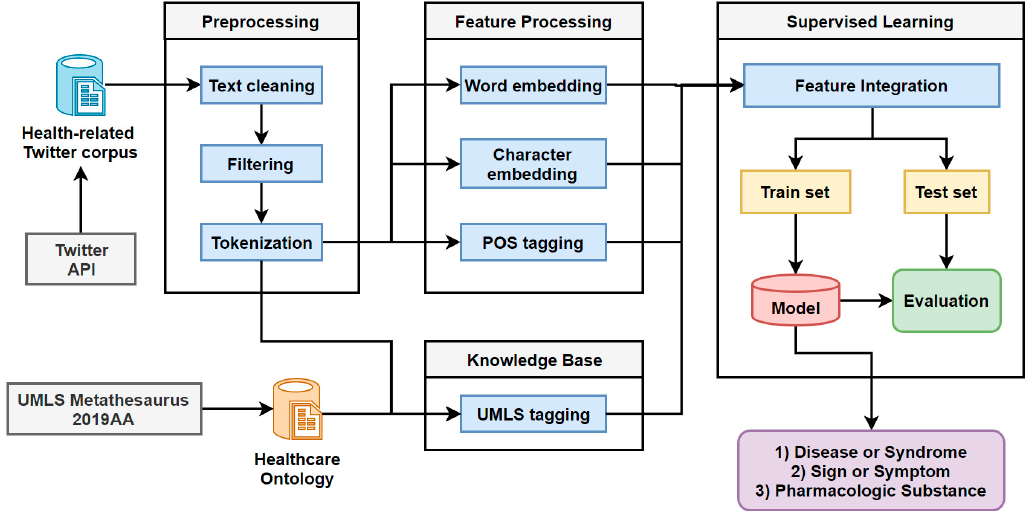
Figure 1. Overflow of HNER. API: application programming interface.